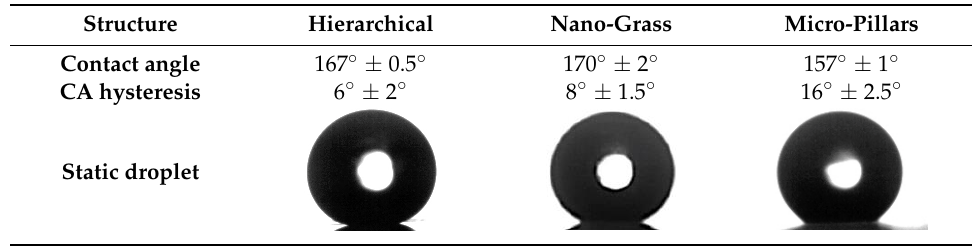
Table 1. The wetting properties of the different structure types: the static contact angle (CA), the contact angle hysteresis while tilting the surface, and a photo of the water droplet resting on the structured surface.